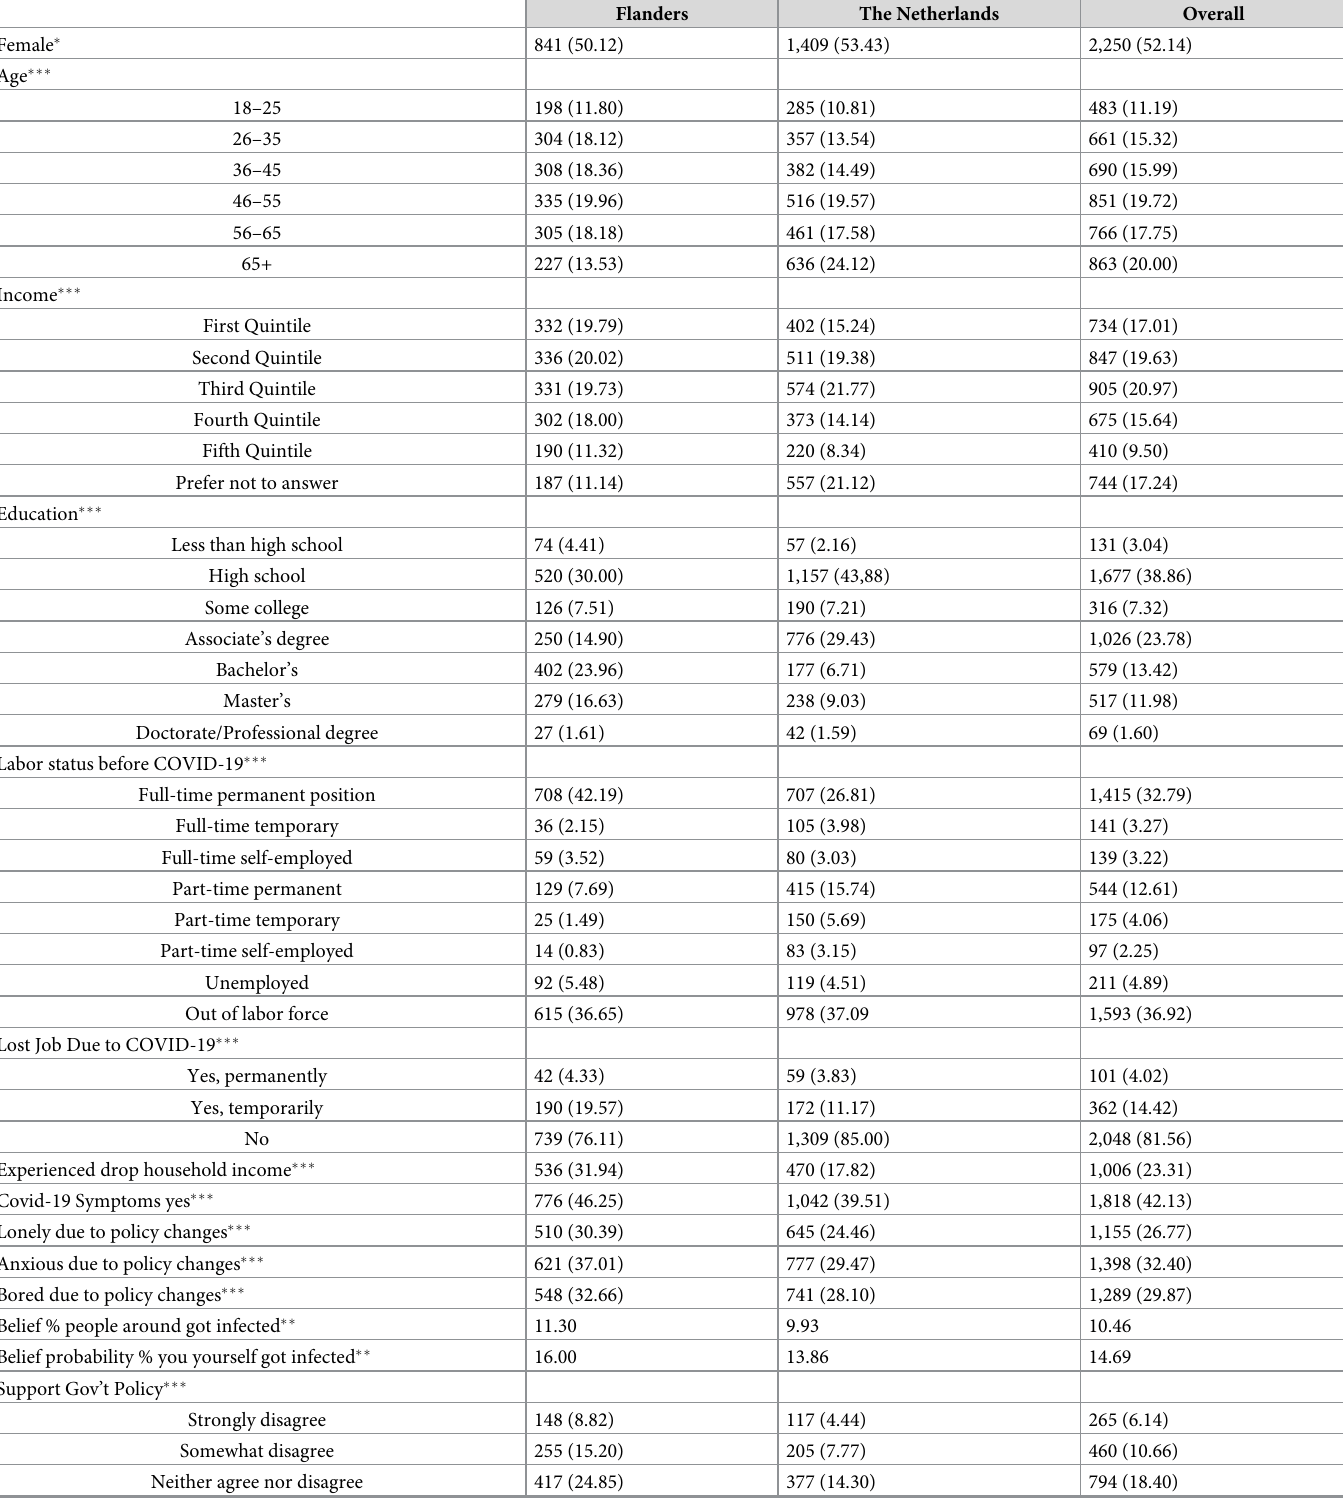
Table 1. Descriptive